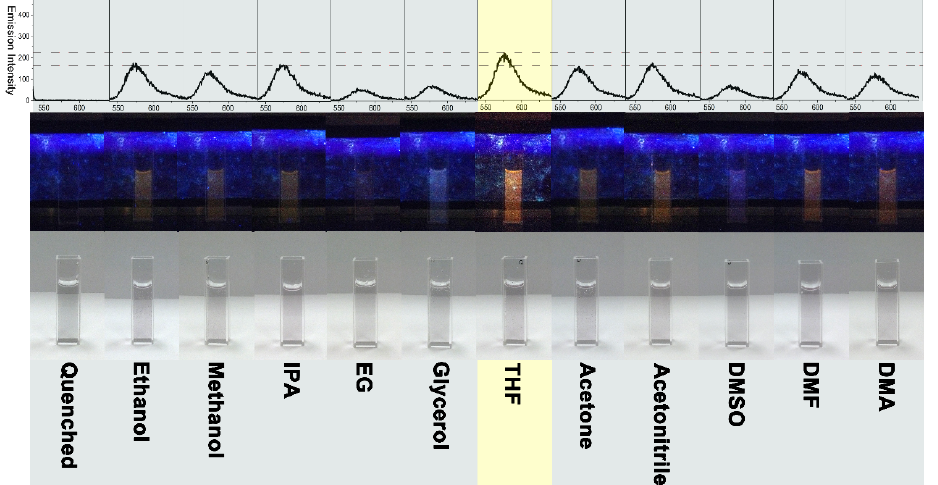
Figure 5. The fluorescent spectra (excitation wavelength of 530 nm, emission peak centered at about 577 nm) are shown in the top row. The corresponding photo images captured under UV light at 365 nm and day light are presented in the middle and bottom rows, respectively. The volume ratio of quenched RhB solution to organic solvent is kept at 2/1. The system with the solvent THF is indicated by yellow shading. The full names of Quenched, IPA, EG, THF, DMSO, DMA and DMA are given as follows: Quenched: quenched RhB solution with CD-G dispersion; IPA: isopropanol; EG: ethylene glycol; THF: tetrahydrofuran; DMSO: dimethylsulfoxide; DMF: dimethyl formamide; DMA: dimethyl